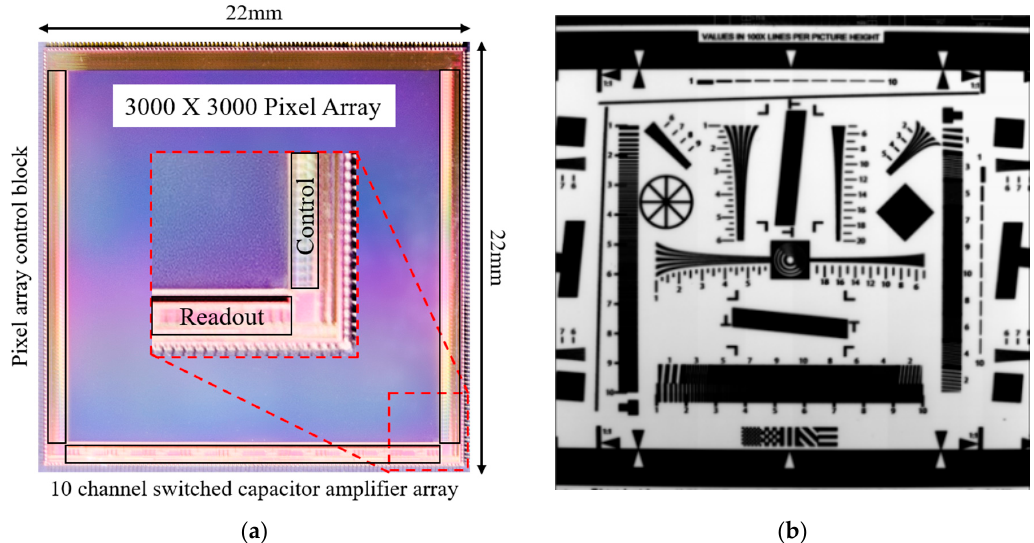
Figure 7. Chip microphotograph and captured image: ( a ) Chip microphotograph including a pixel array, pixel control block, and switched capacitor amplifiers of 10 channels; ( b ) Captured image (ISO 12233 chart).